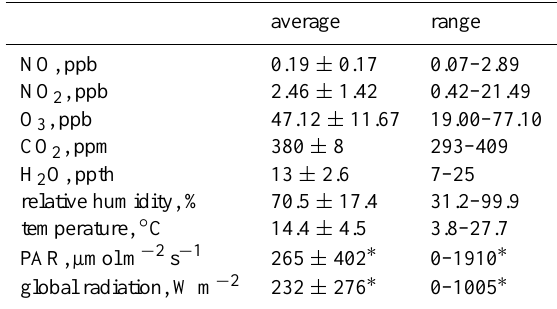
Table 1. Overview of the ambient measurements. Parameters were measured near the dynamic plant chambers (16m above ground within the canopy) except for global radiation, which was recorded above the canopy (31m above